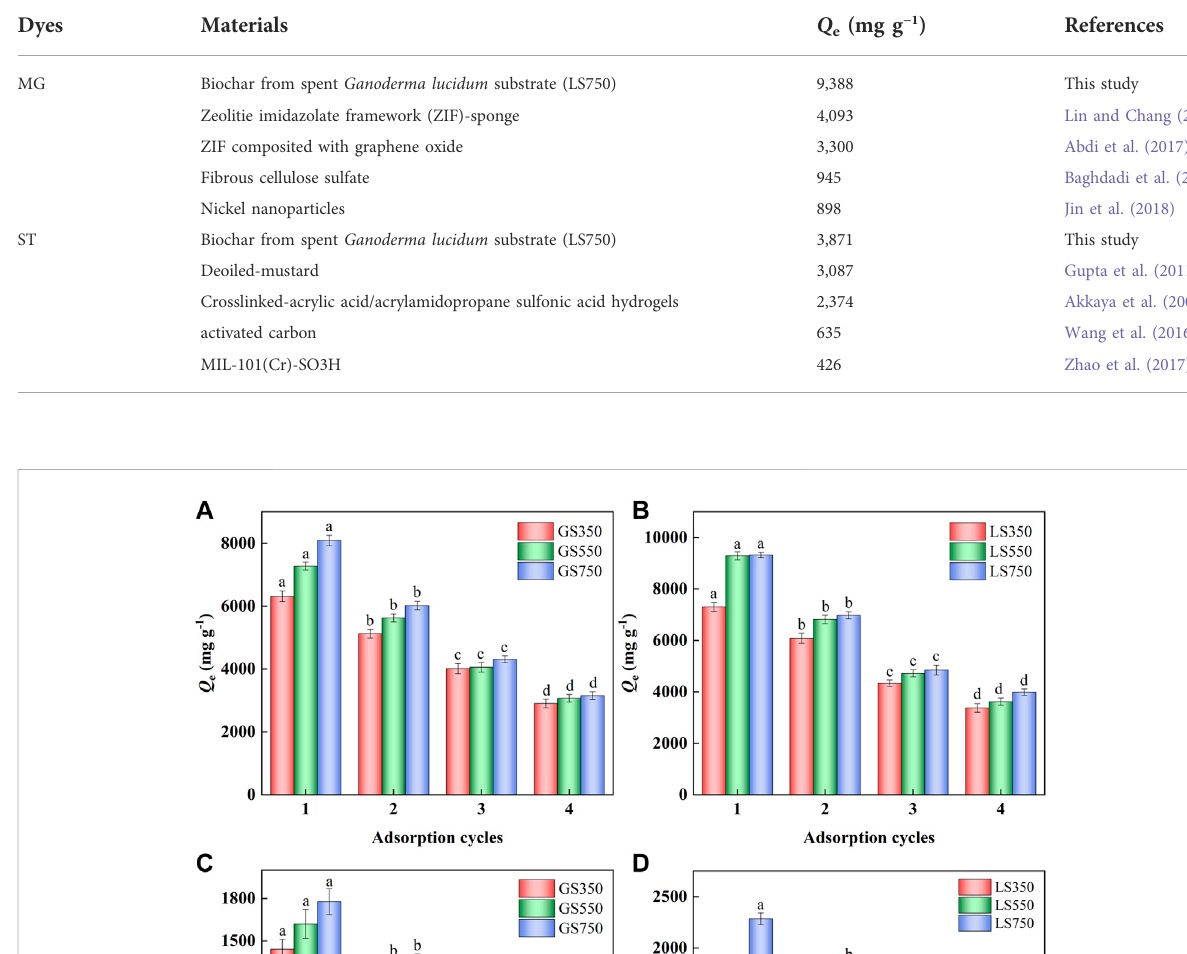
TABLE 2 Maximum adsorption capacity of MG and ST by various adsorbents.